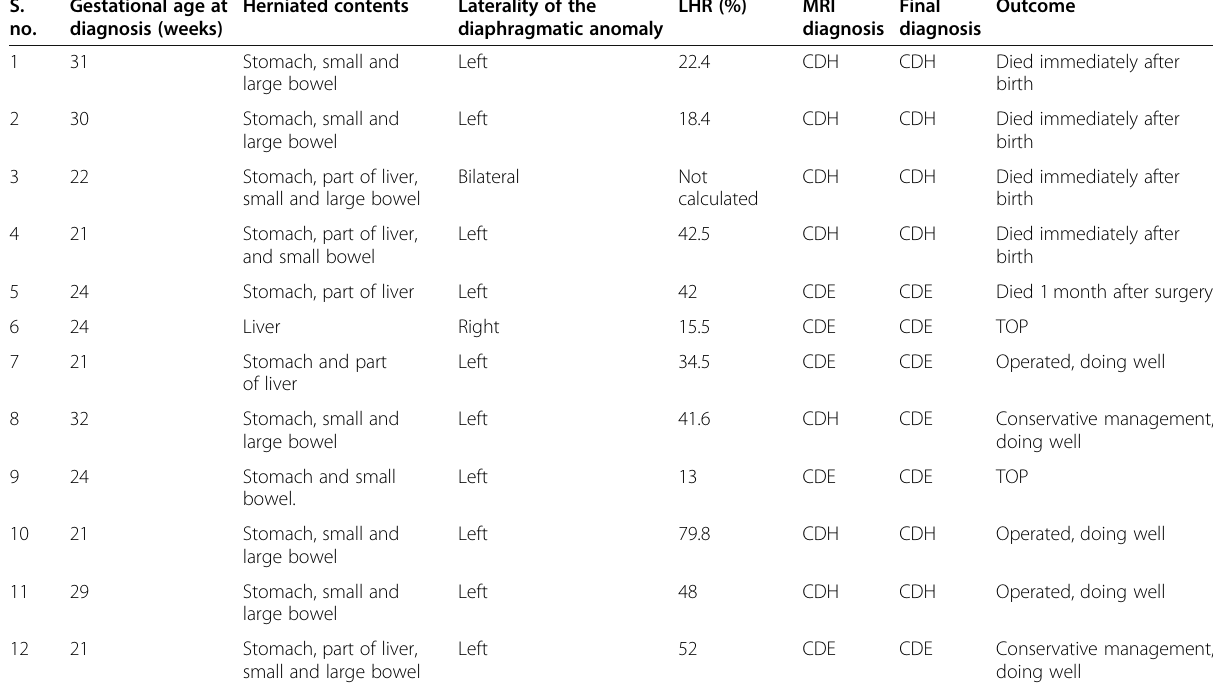
Table 1 Demography, imaging findings, postnatal outcome, and follow-up details of patients with fetal diaphragmatic anomalies included in the